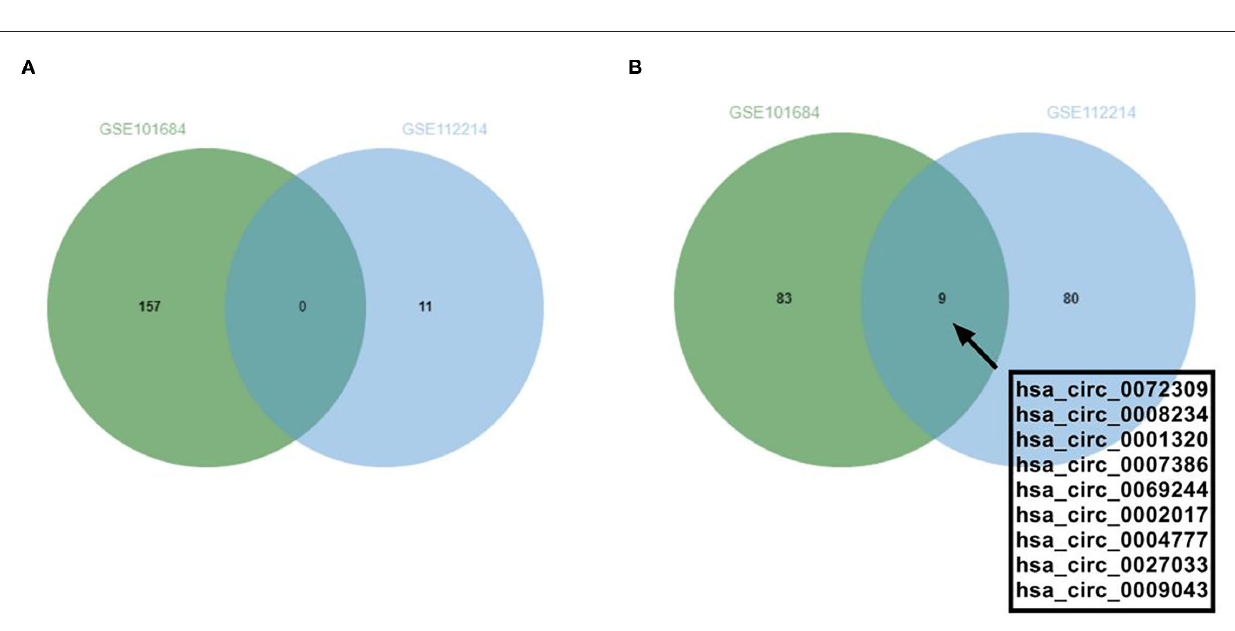
( Table 2 , Figures 2A,B ). In order to find shared differentially expressed circRNAs, we drew a Venn diagram to find zero shared highly expressed circRNAs in the two microarrays while nine common lowly expressed circRNAs ( Figures 3A,B ). hsa_circ_0072309 with the most significant difference and the largest LogFC was selected for follow-up